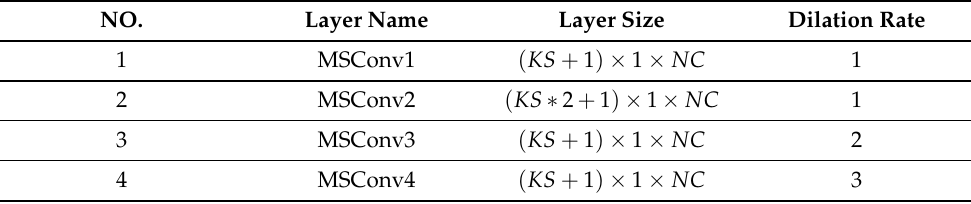
Table 1. Architecture-related hyperparameters of DMSconv